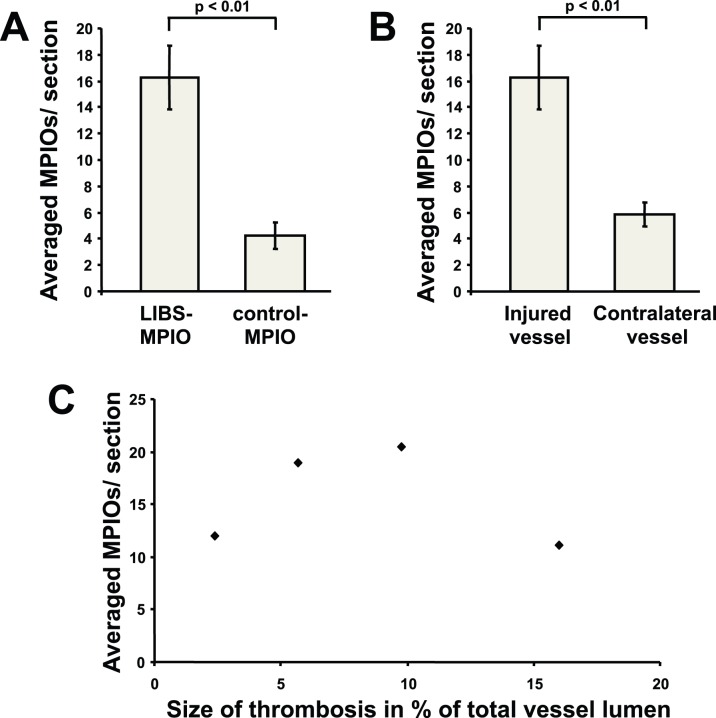
Quantification of MPIOs on histological sections.MPIOs were about four-fold more abundant in animals with LIBS-MPIO-injection as compared to the animals receiving control-MPIO. A similar difference was observed between injured and non injured vessels in animals receiving LIBS-MPIO. Correlation of thrombus size with the number of bound MPIOs in animals with LIBS-MPIO injection is not significant; however the number of MPIOs is in average within a similar range of 10–20 MPIOs per section as expected from the observed signal attenuation.